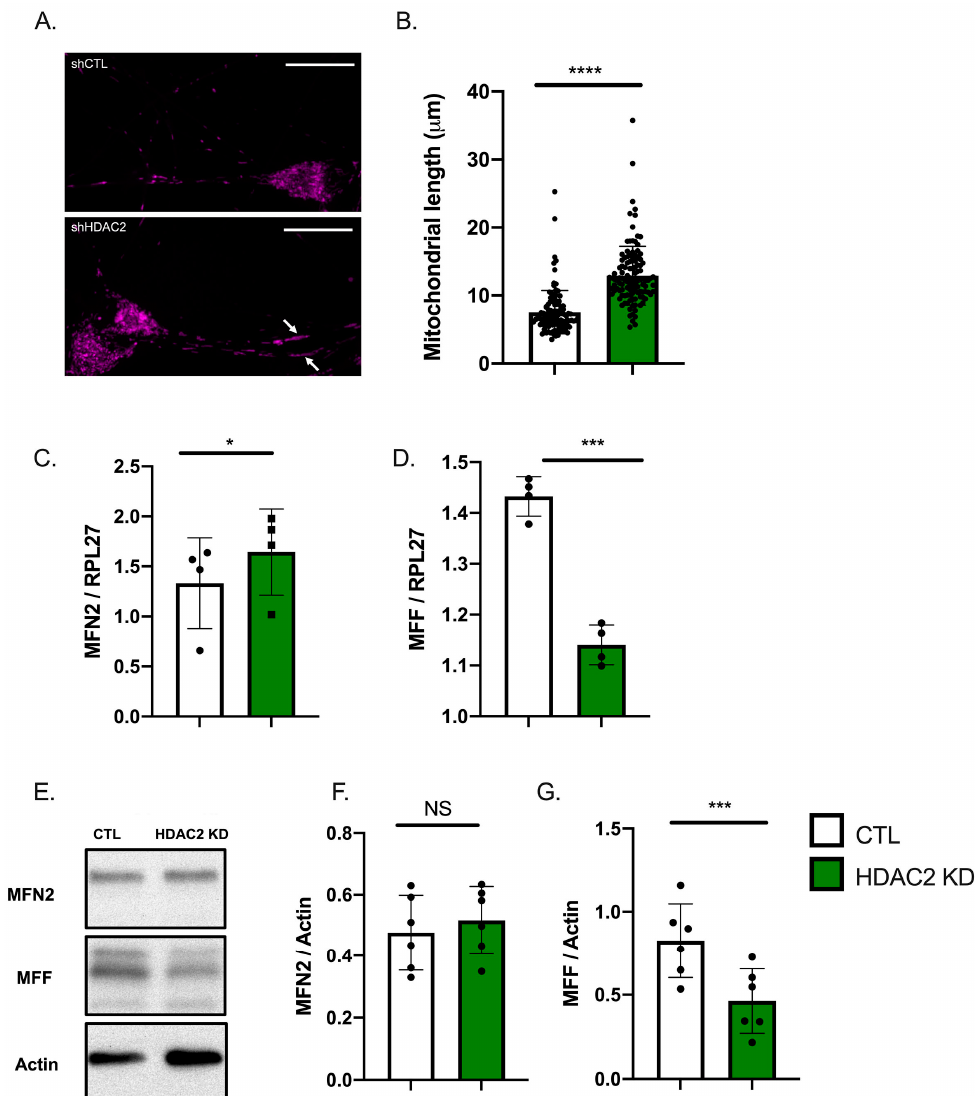
Figure 4. Knock-down of HDAC2 in hiPSC-derived neurons leads to elongated mitochondria in neurites and influences expression of genes involved in mitochondrial dynamics. ( A ). Representative image of elongated mitochondria visualized with Mitotracker in hiPSC-derived neurons with HDAC2 KD vs. CTL shRNA. ( B ). Quantification of mitochondrial length in neurites ( N = 4 independent Mitotracker experiments, 59 control mitochondria and 57 HDAC2 KD mitochondria, **** p < 0.0001 by Mann–Whitney U test). ( C ). qRT-PCR analysis of Mitofusin 2 ( MFN2 ) expression in HDAC2 KD (Each dot represents the mean of 4 independent experiments, * p < 0.05 by t -test). ( D ). qRT-PCR analysis of Mitochondrial Fission Factor ( MFF ) expression in HDAC2 KD (Each dot represents the mean of 4 independent experiments, *** p < 0.001 by paired t -test). ( E ). Representative Western blot analysis of MFN2 and MFF protein expression in CTL vs. HDAC2 KD conditions. ( F , G ). Quantification of MFN2 and MFF protein levels: MFN2 protein levels are unchanged in HDAC2 KD ( N = 6, NS = not significant by t -test). MFF protein levels are decreased in HDAC2 KD ( N = 6, *** p < 0.001 by t -test). Scale bar = 20 μ m.